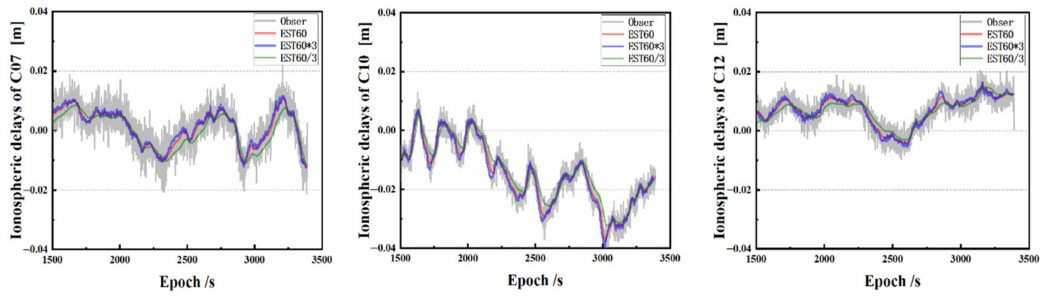
Figure 11. The ionospheric delays time series of C07, C10 and C12 from the solution EST60, EST60 × 3 and EST60 ÷ 3.